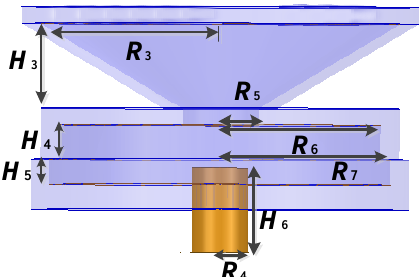
Figure 9. Cross section of the hollow cone loaded cylinder cavity.